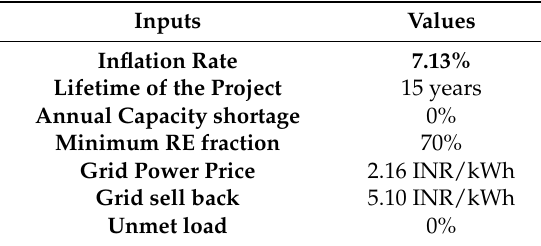
Table 1. The inputs used for economic analysis using HOMER and iHOGA.